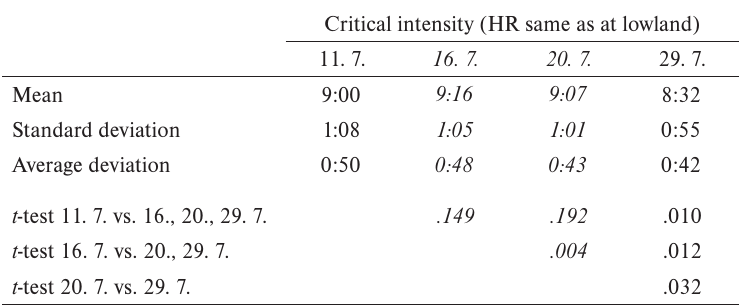
Summary of times for individual tests at critical intensity with identical HR Critical intensity (HR same as at lowland)